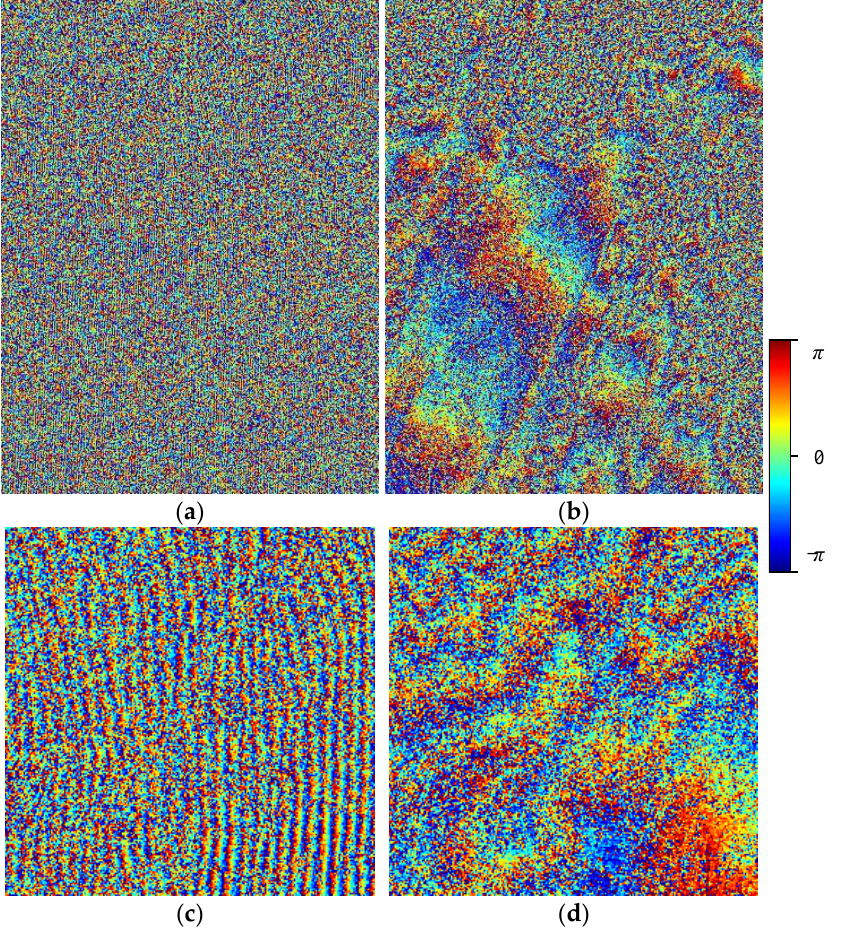
Figure 3. Interferograms of the experimental Gaofen-3 satellite data in the Dengfeng area, China: ( a ) interferogram, ( b ) flattened interferogram, ( c ) local part of the interferogram, ( d ) local part of the flattened interferogram.